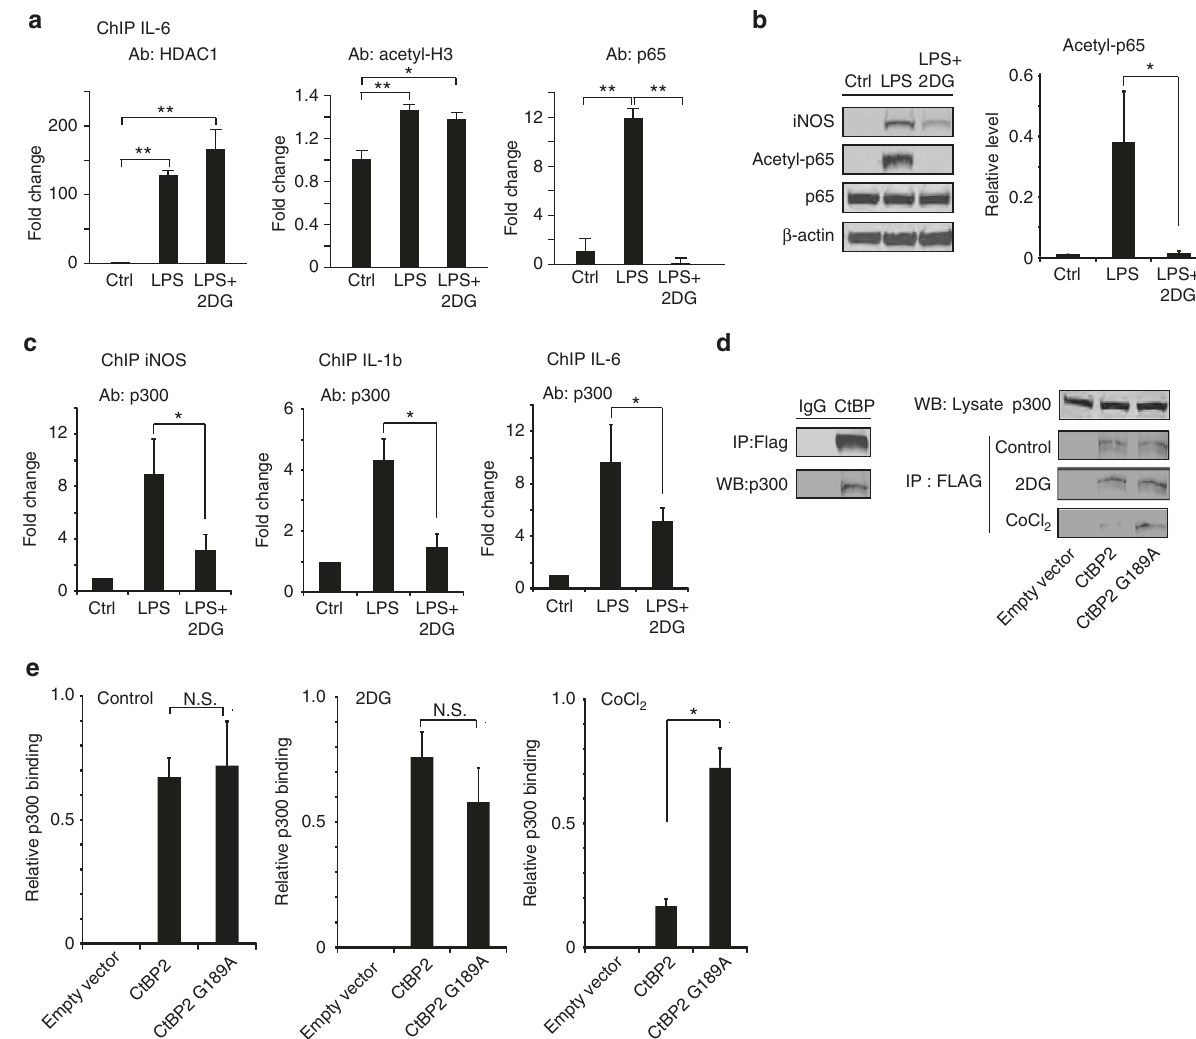
Fig. 8 CtBP effects on p300 and NF- κ B acetylation. a Chromatin immunoprecipitation (ChIP) with antibody to HDAC1, acetyl H3, and p65 was performed in RAW264.7 cells to evaluate binding to the IL-6 promoter regions. LPS increased all three signals, but only the effect of p65 binding was reversed by 2DG (conditions as in Fig. 1c); n = 3, * p < 0.05. b Western blots show LPS-induced p65 acetylation is suppressed by 2DG (conditions as in Fig. 1c); n =